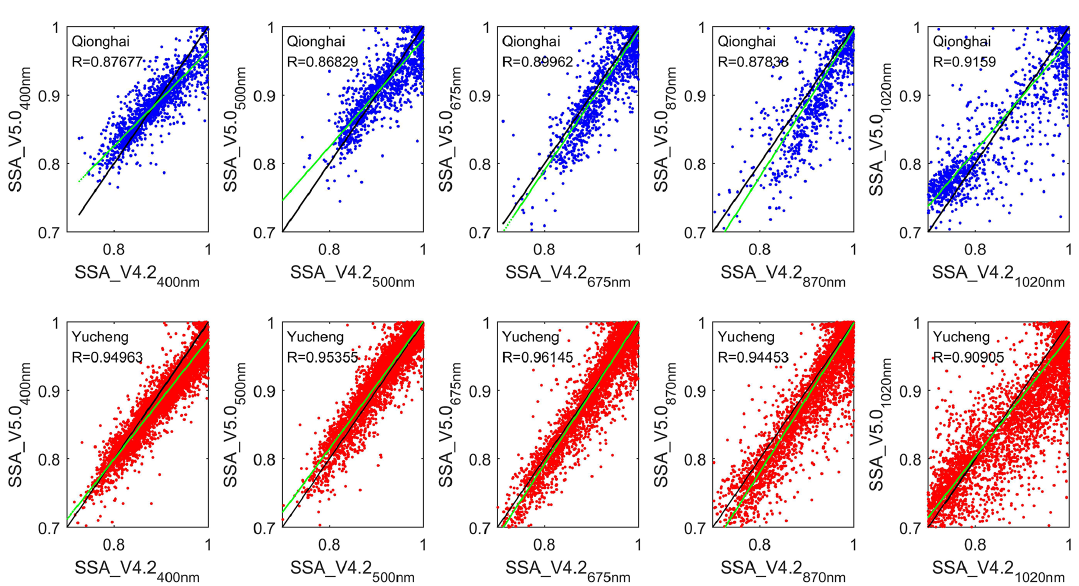
Figure 6. Scattergrams of the single scattering albedo retrieved by SKYRAD V4.2 and V5.0 at wavelengths of 400, 500, 670, 870, and 1020nm over Qionghai and Yucheng during February 2013 to December 2015. Only data with AOD 500nm >0.2 are shown. The green line indicates the fitted linear regression